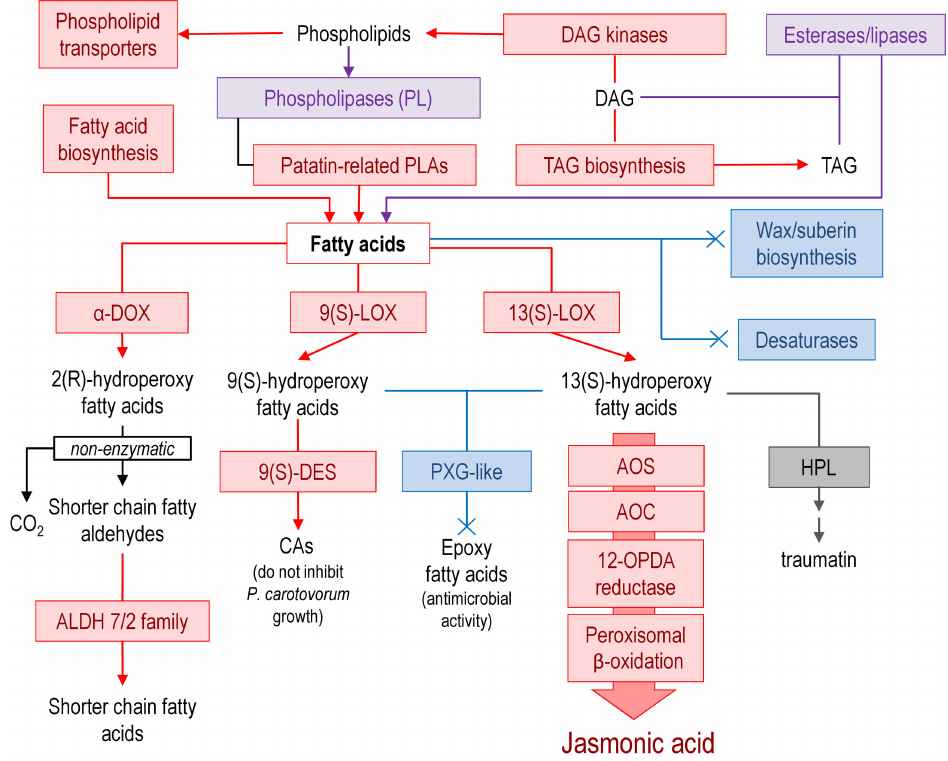
Figure 5. Regulation of genes related to the metabolism of lipids and oxylipins in tobacco plants infected by P. atrosepticum . The reactions catalyzed by the enzymes encoded by mostly upregulated, mostly downregulated, non-DEGs, and both up- and downregulated DEGs are marked in red, blue, gray, and purple, respectively. ALDH, aldehyde dehydrogenase; PLA, phospholipase A; α -DOX, α -dioxygenase; CAs, colneleic and colnelenic acids; DAG, diacylglycerol; TAG, triacylglycerol; 12-OPDA, 12-Oxo-phytodienoic acid; PXG, peroxygenase; LOX, lipoxygenase; AOS, allene oxide synthase; AOC,alleneoxidecyclase; DES,divinylethersynthase; HPL,hydroperoxidelyase. Thescheme was assembled based mostly on KEGG reference pathways as well as the SwissProt database and sources of literature cited in the